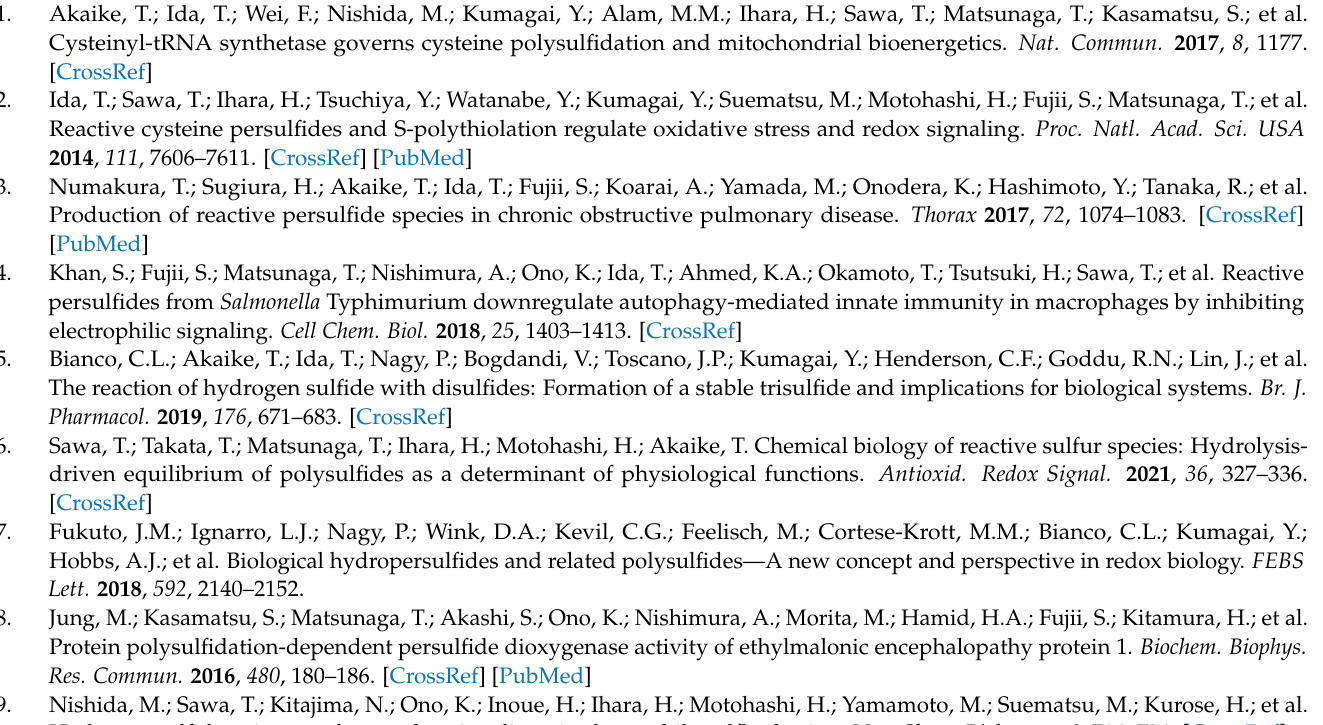
CARS2 expression; Figure S2: Sulfur metabolome analysis in CSE KO mice; Table S1: Primers used for different genotypes of KO mice; Table S2: MRM parameters used for LC-ESI-MS/MS